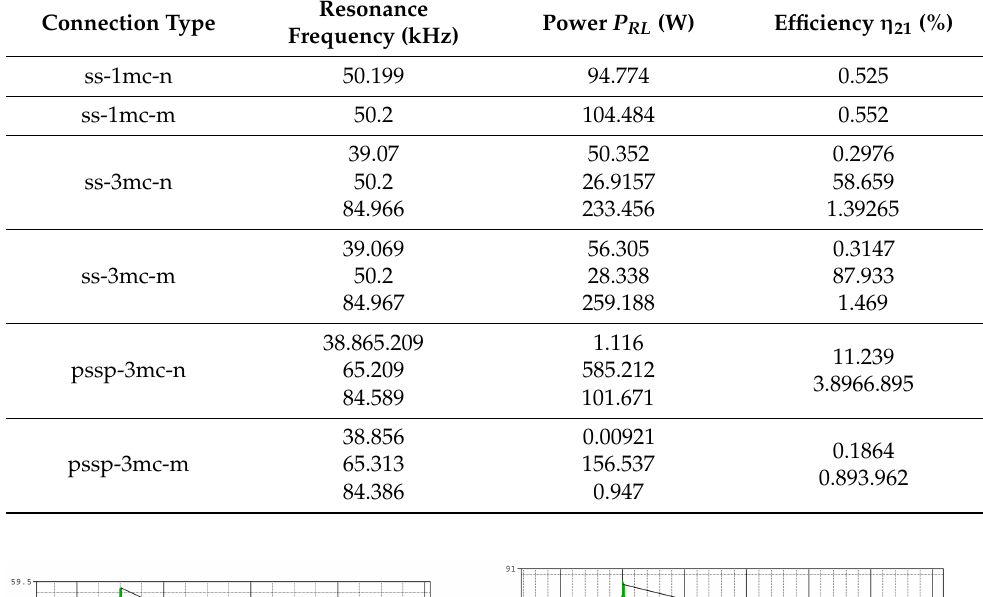
Table 2. The load transferred power and the efficiency in conditions of resonance.